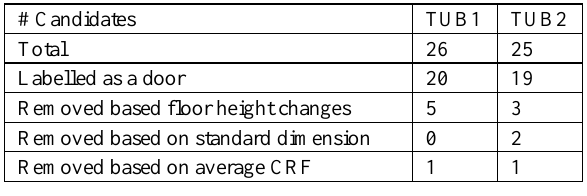
Table 3. A report of the proposed method performance